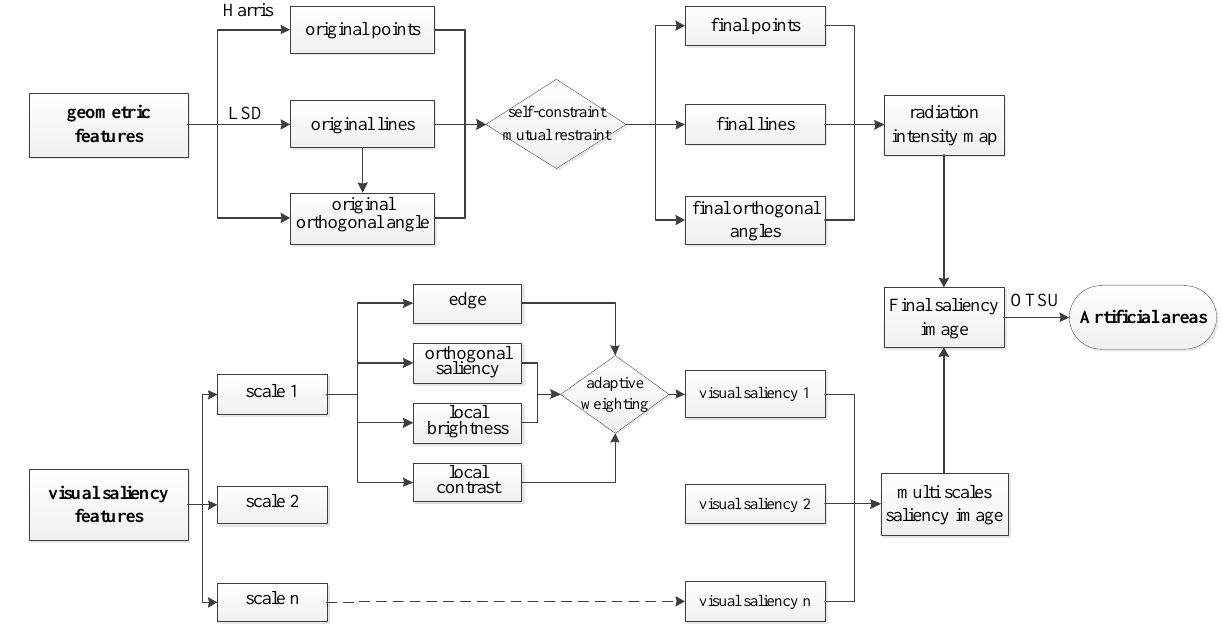
Fig.1 Flaw chart of artificial area detection based on multi scale and multi feature